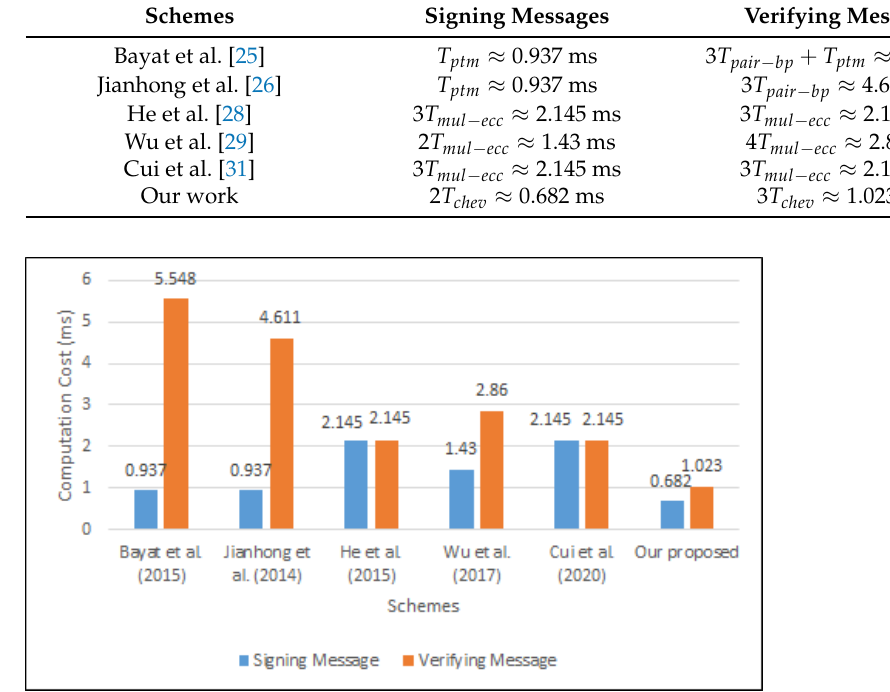
Figure 6. Analysed schemes